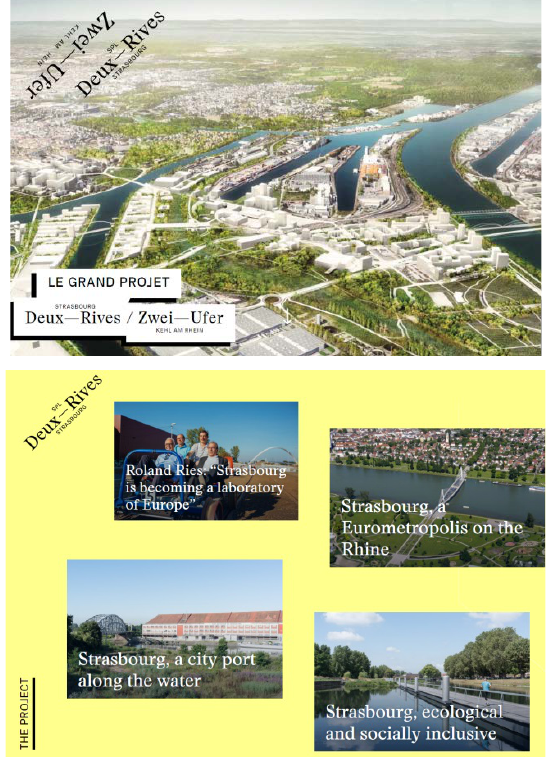
Figure 2. An overview of the Deux Rives Project and details